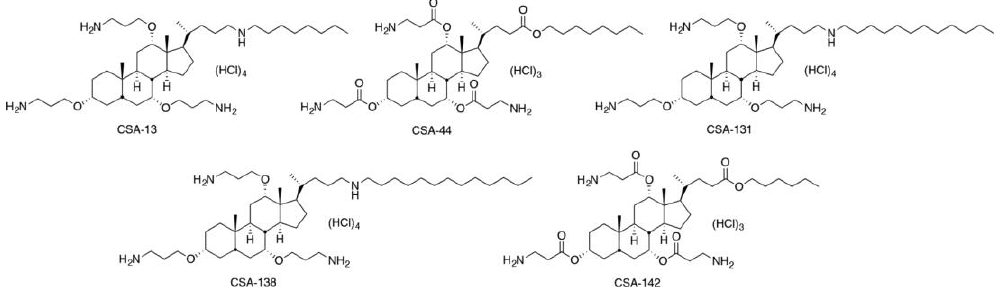
Figure 1. Structure of ceragenins used in this study.